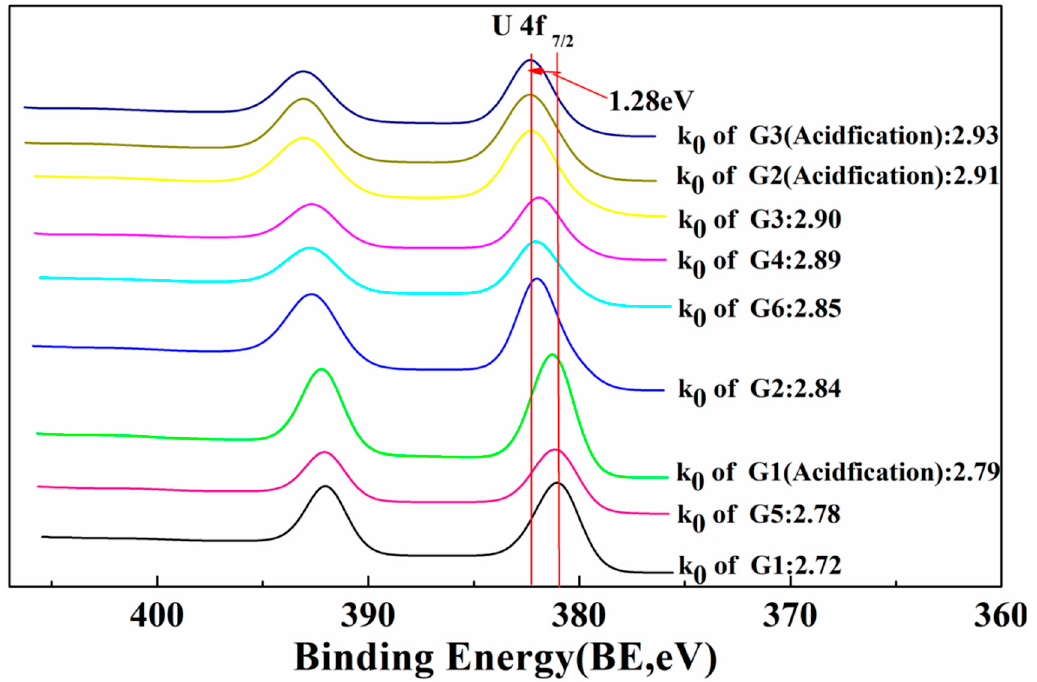
Figure 16. The variation of the U 4f spectra along with oxygen coefficient (k 0 ).